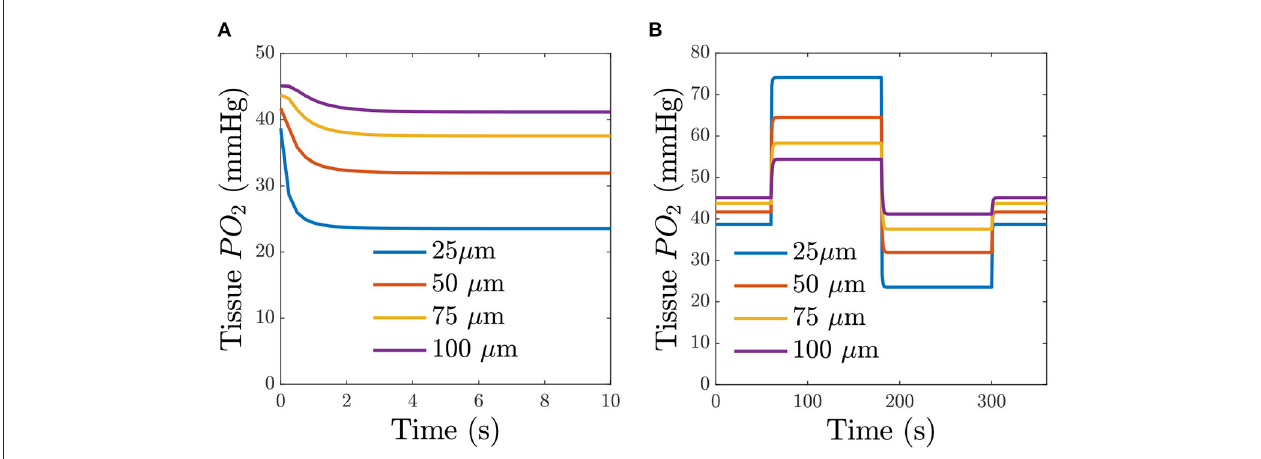
FIGURE 8 | Predicted time-dependent changes in tissue O 2 . (A) Predicted tissue PO 2 for a step change in chamber O 2 for different depths from the glass slide. (B) Predicted tissue PO 2 in response to a square wave in chamber O 2 . The square-wave consisted of 1 min of 5% O 2 , 2 min of 12% O 2 , 2 min of 2% O 2 , and 1 min of 5% O 2 . The legend indicates the depth from the surface of the exchange window.